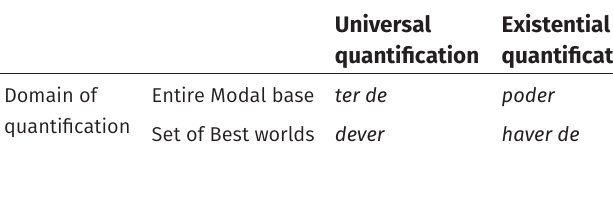
Table 2: Modal verbs in Portuguese and domain of